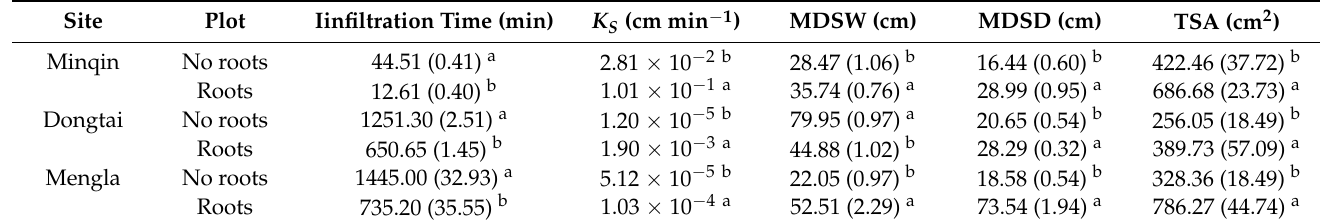
Figure 1. Soil water distribution patterns were significantly affected by the fibrous roots of maize ( A ), the fine roots of rubber ( B ), and the smooth roots of Spartina alterniflora ( C ) [50]. Table 4. Effects of roots on the measured parameters (mean ± SE, n = 3)